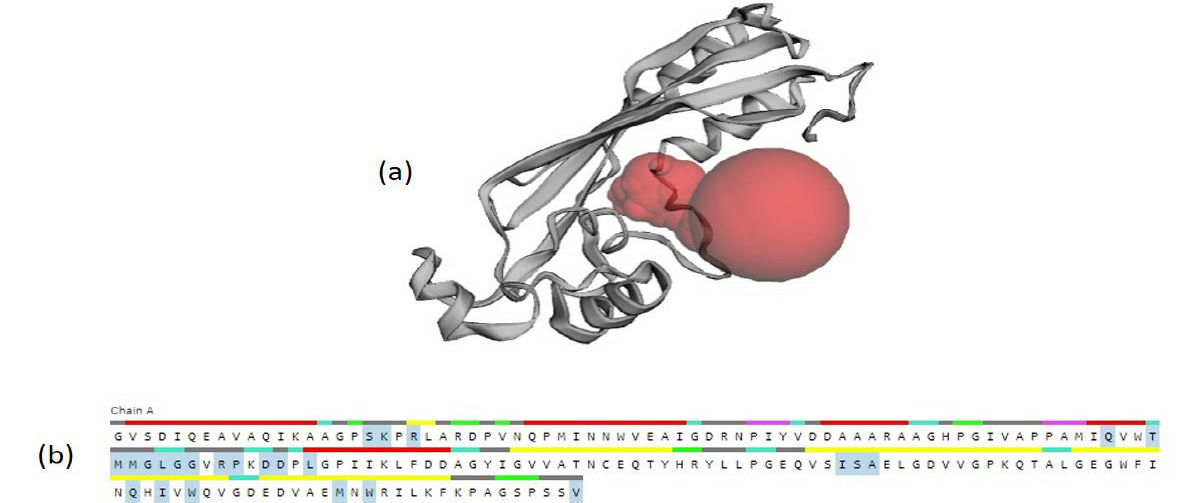
Fig. 1. The active site of the protein in red color(a) and amino acid residues of active sites in blue(b) of the uncharacterized protein